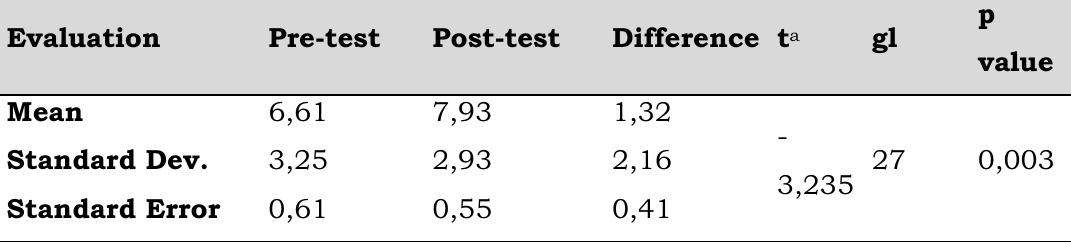
Table 2. Difference between the pre and